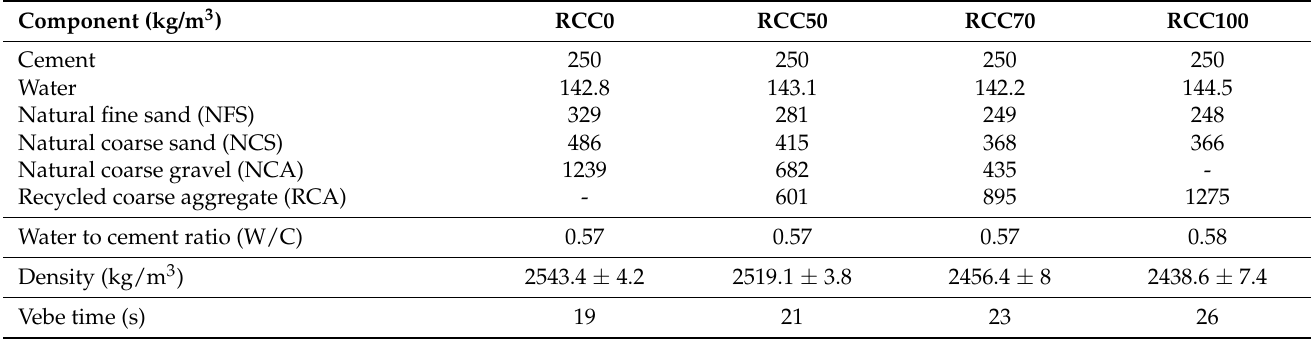
Table 2. Mix proportions pf roller compacted concrete